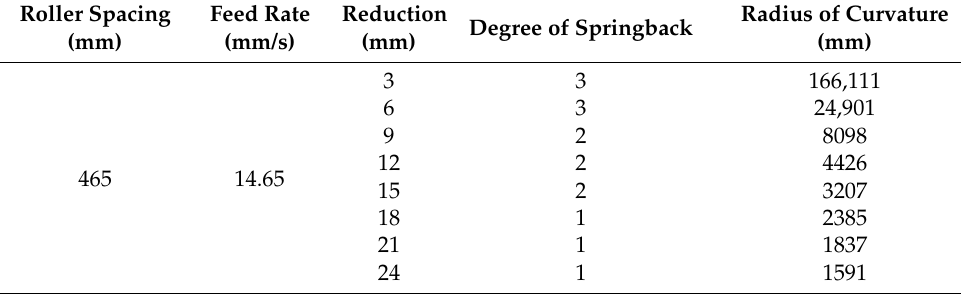
Table 2. Dataset after adding new features.